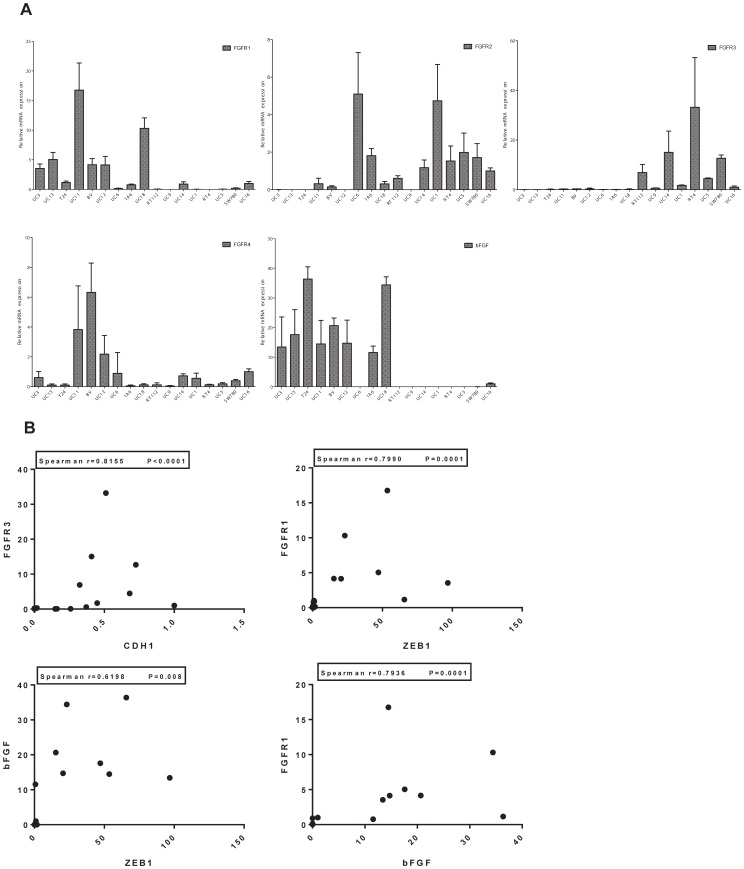
Relationship between FGFR/bFGF expression and EMT.A. Expression of FGFRs 1–4 and bFGF in relationship to E-cadherin expression. The relative mRNA levels were measured by quantitative real-time RT-PCR. The cell lines in each panel are organized by relative E-cadherin expression (low to high, from left to right; see Fig. 1B). B. Scatterplots depicting the relationships between FGFR1, bFGF, FGFR3, and EMT marker expression. Nonparametric correlation analyses were used to evaluate the relationships between FGFR3 and E-cadherin (CDH1) expression, FGFR1 and ZEB1 expression, bFGF and ZEB1 expression, and bFGF and FGFR1 expression. Correlation coefficients and p values are indicated on the figure.